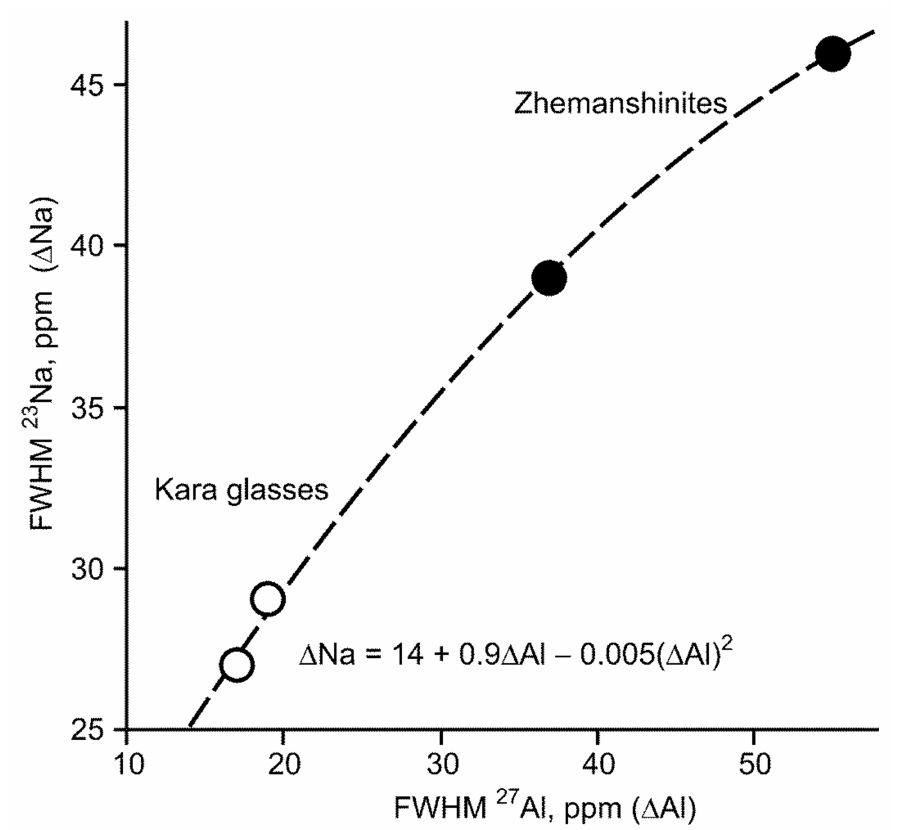
Figure 4. The FWHM plot of the 23 Na NMR central bands vs. FWHM of the 27 Al NMR central bands of the impact